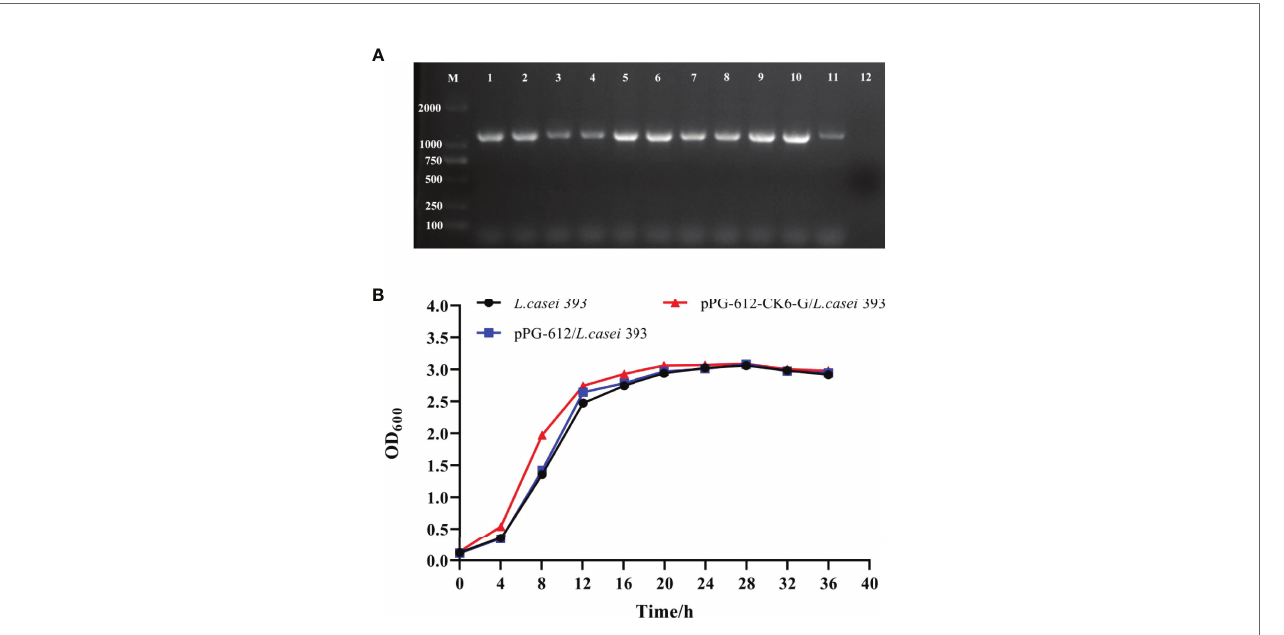
FIGURE 2 | Genetic stability and growth of pPG-612-CK6-G/ L.casei 393. (A) Identi fi cation of samples taken at different times for 50 consecutive generations, line 1: fi rst generation sap; line 2: the 5th generation sap; line 3: the 10th generation sap; line 4: the 15th generation sap; line 5: the 20th generation sap; line 6: the 25th generation sap; line 7: the 30th generation sap; line 8: the 35th generation sap; line 9: the 40th generation sap; line 10: the 45th generation sap; line 11: the 50th generation sap; line 12: blank control; M: DNA marker DL2000; (B) Growth curves of pPG-612-CK6-G/ L.casei , pPG-612/ L.casei and L.casei over 36 h.